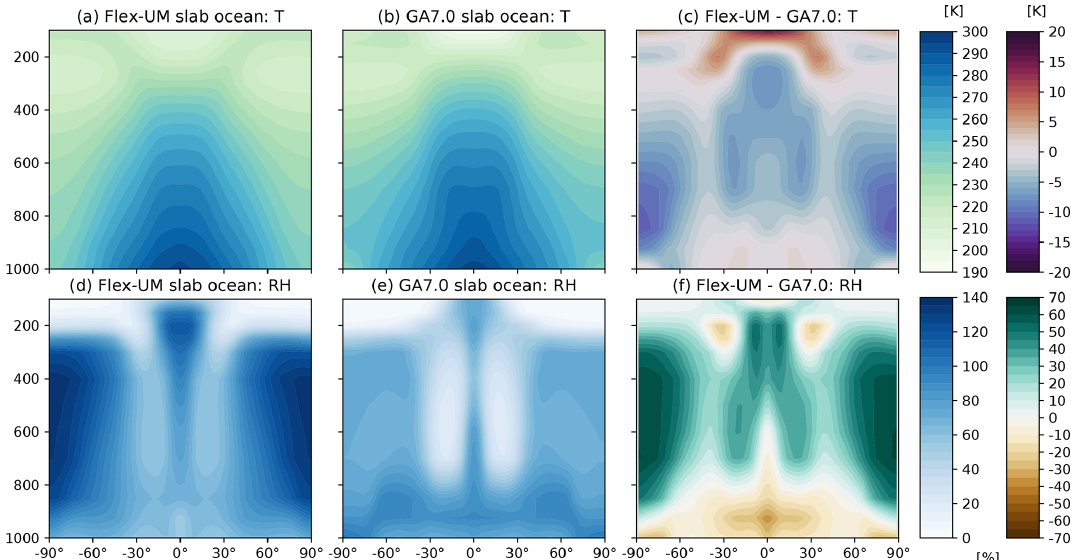
Figure 9. Slab-ocean aqua-planet model climatologies for Flex-UM (a, d) and GA7.0 (b, e) for temperature ( T in K , a, b, c ) and relative humidity (RH as a %, d, e, f ) on their native model grids. The differences between the models (Flex-UM – GA7.0) are plotted in panels (c, f) and are interpolated onto the Flex-UM grid. Subplots in panels (a) and (d) are identical to those in Fig. 3a and d but are shown here for ease of comparison.